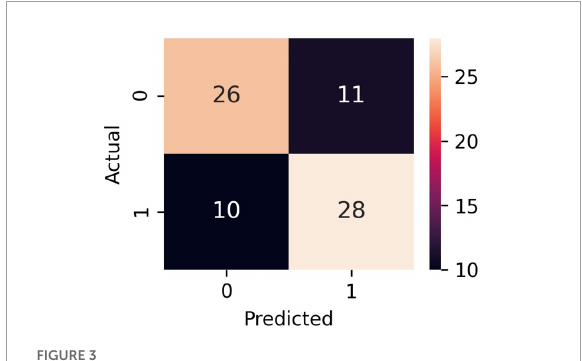
FIGURE3 Confusion matrix of the LR model. Classes 0 and 1 are recompensated and decompensated CHF phases, respectively.